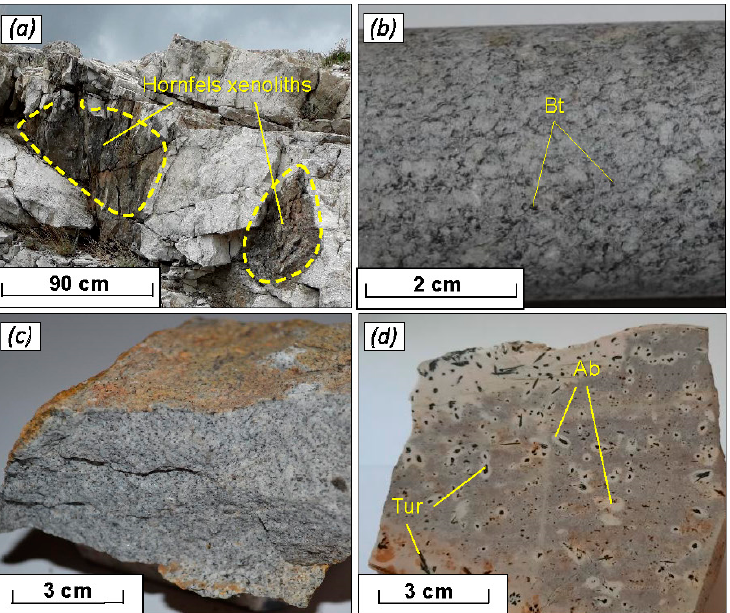
Figure 5. Na-granites from the Tochka area. ( a ) Outcrop of Na-granites with hornfels xenoliths; ( b ) core samples of medium-grained biotite (Bt) Na-granite; ( c ) quartz porphyry dike with albite and quartz phenocrysts; ( d ) quartz albitophyre dike with albite (Ab) spherulites that enclose tourmaline (Tur) (schorl).